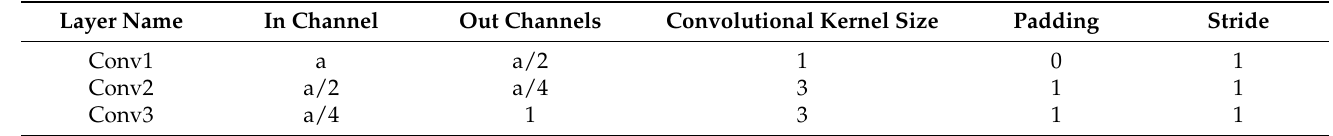
Table 1. Convolutional architecture in self-attention